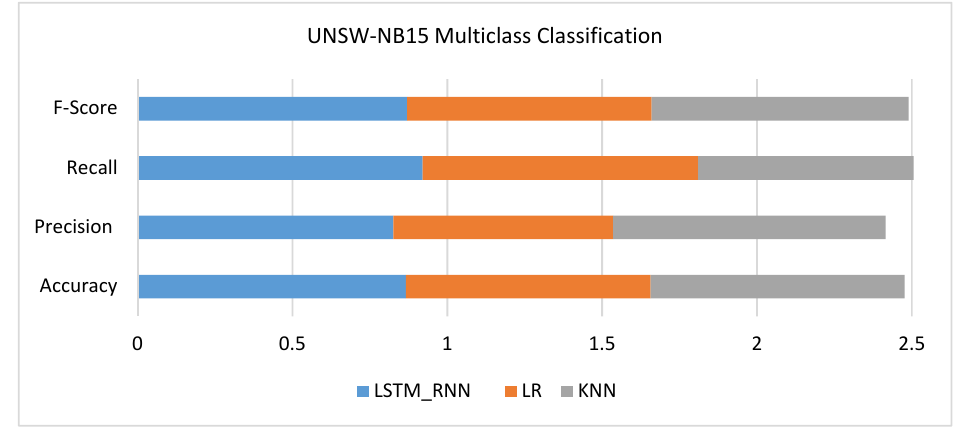
Figure 13. UNSW-NB15 Multiclass classification performance comparison. Here is another set of experiments targeting the three algorithms’ performance based on the UNSW-NB15 detailed attacks. As shown in Figure 14, LSTM_RNN showed a great overall performance of the attacks presented in the UNSW-NB15 dataset. On average, LSTM_RNN outperformed KNN by 2% accuracy while it outperformed LR, on average, by 5% accuracy.